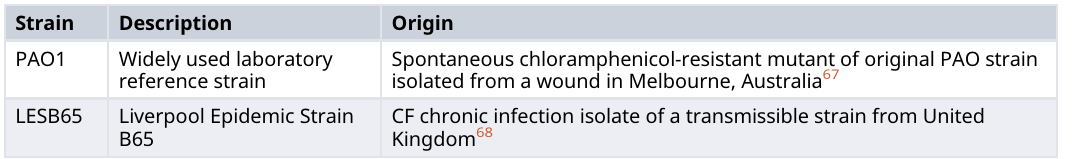
Table 1. Bacterial strains used in this